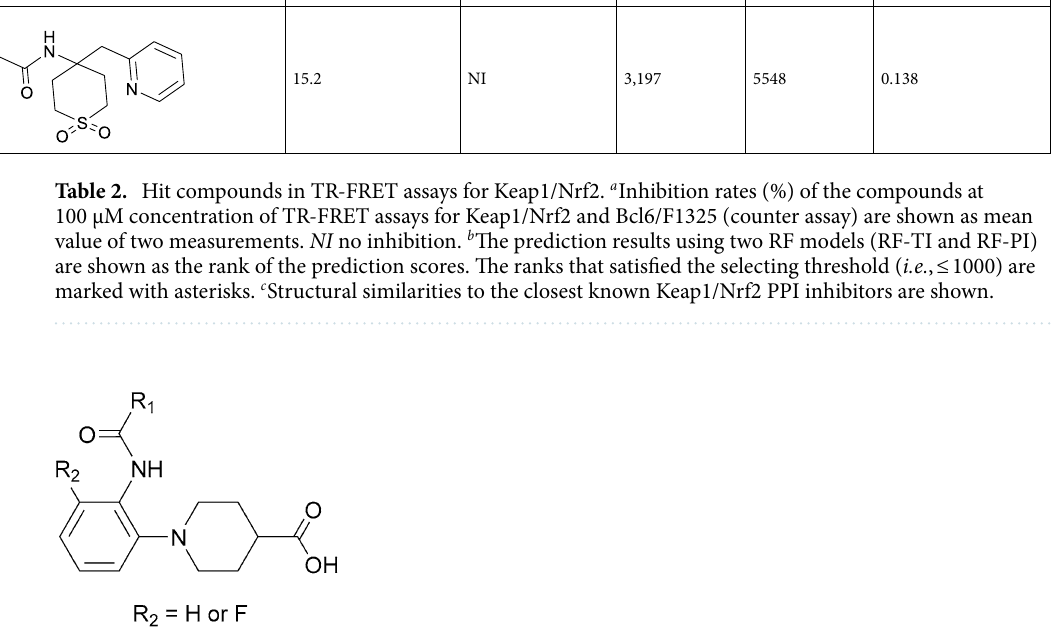
Figure 4. A common substructure of five hit compounds ( 2 , 3 , 5 , 8 , and 11 ). The uncommon part is shown as R 1